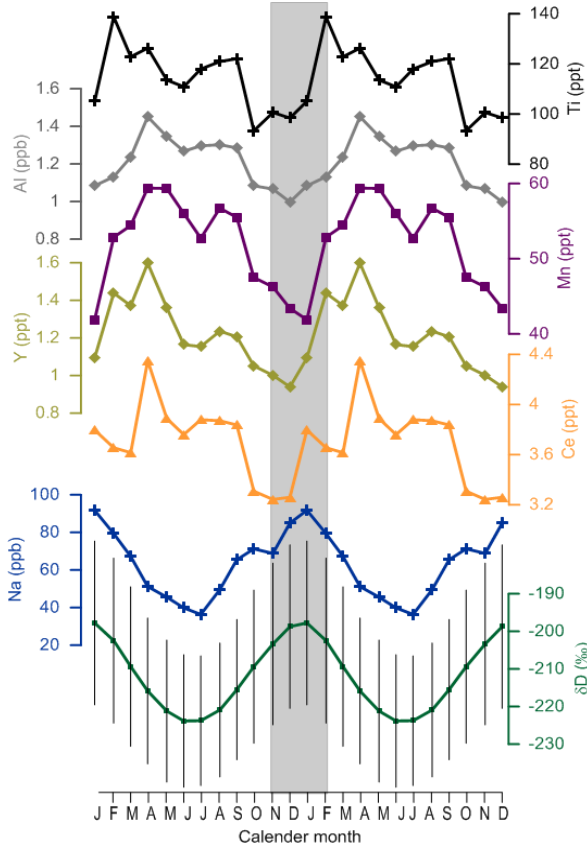
Figure 5: Mean seasonal cycles of δ D, marine aerosol (Na) and lithophile elements (Ce, Y, Mn, Al and Ti) for 1970 – 2005 AD. Two cycles are plotted to aid viewing. δ D has been back-diffused to correct for minor changes in amplitude and phasing of seasonal cycles resulting from molecular diffusion. δ D error bars represent the standard deviation of each monthly mean value. Standard deviations of the monthly means are greater than the amplitude of seasonal cycles for Na, Ce, Y, Mn, Al and Ti.